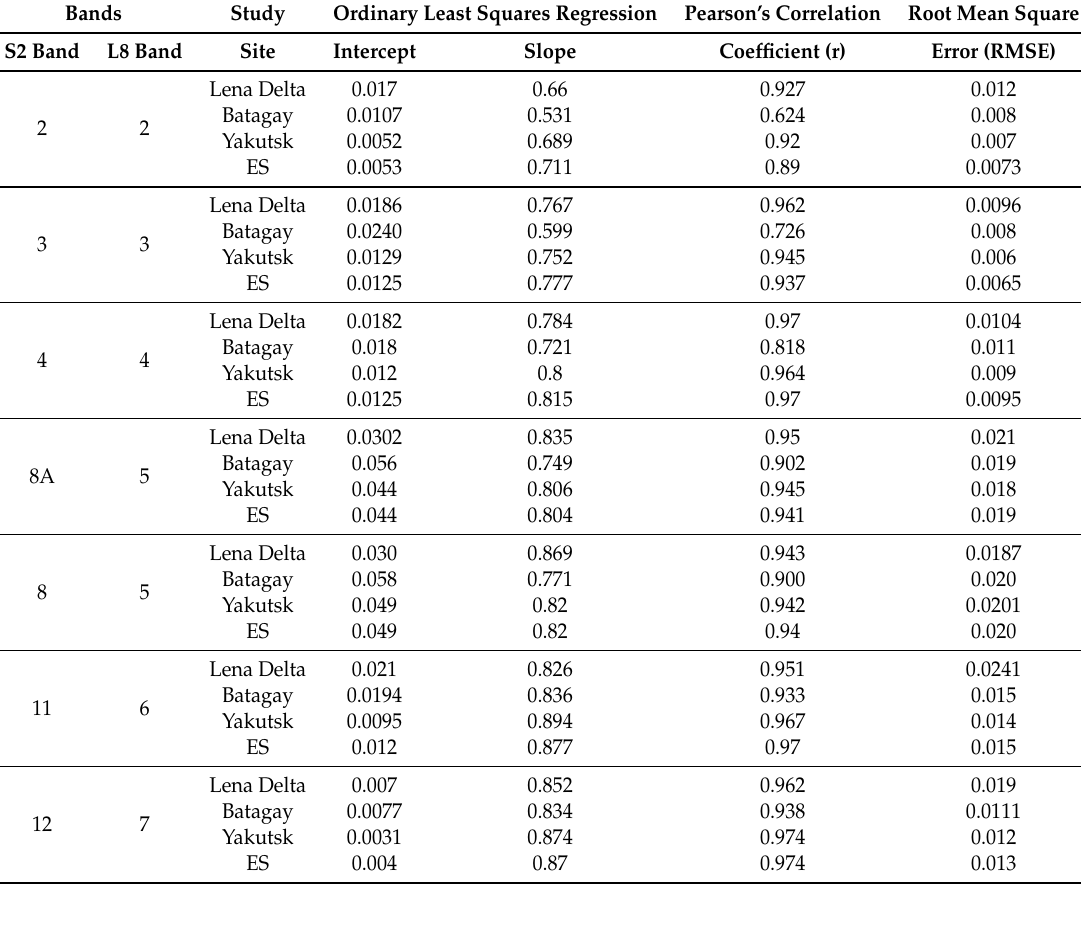
Table 3. Comparison of surface reflectance values from the Sentinel-2 and Landsat-8 corresponding bands, for same-day acquisitions. Displaying the results of the ordinary least squares regression, Pearson correlation, and root mean squared error for every study site.